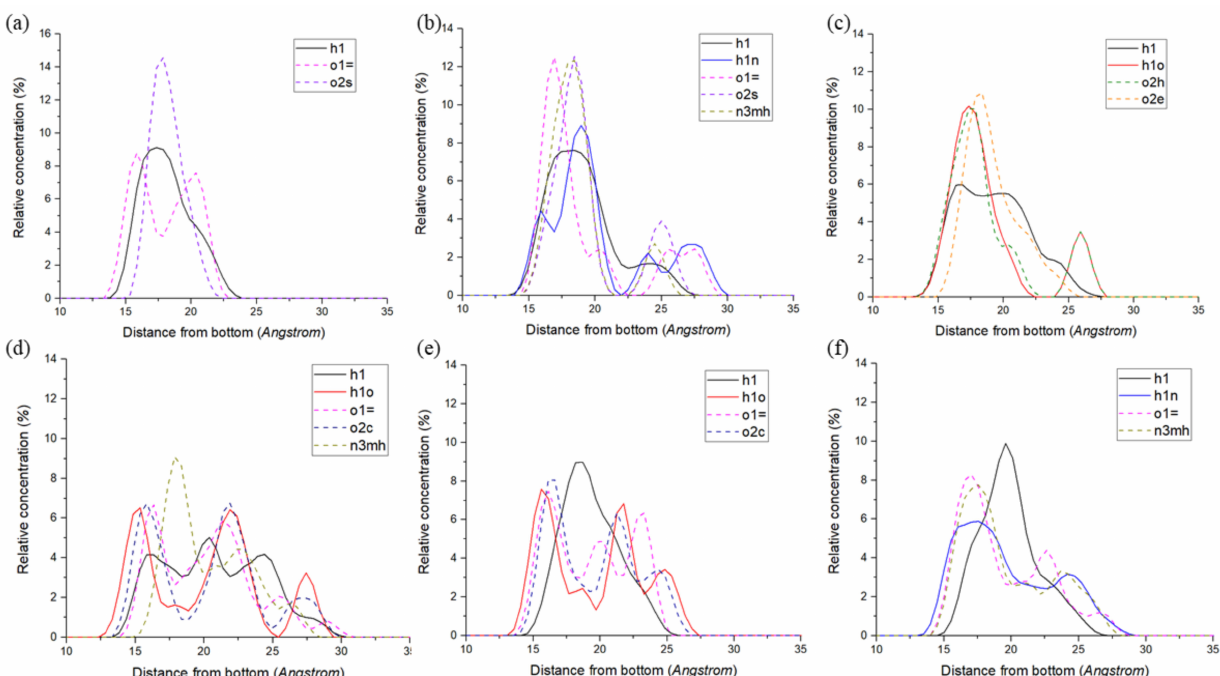
Figure 1. Density distribution of six polymers in the direction perpendicular to the surface of quartz crystal (z direction): ( a ) PVAc, ( b ) PU, ( c ) HPMC, ( d) PASP, ( e ) PAA, ( f ) PAM.